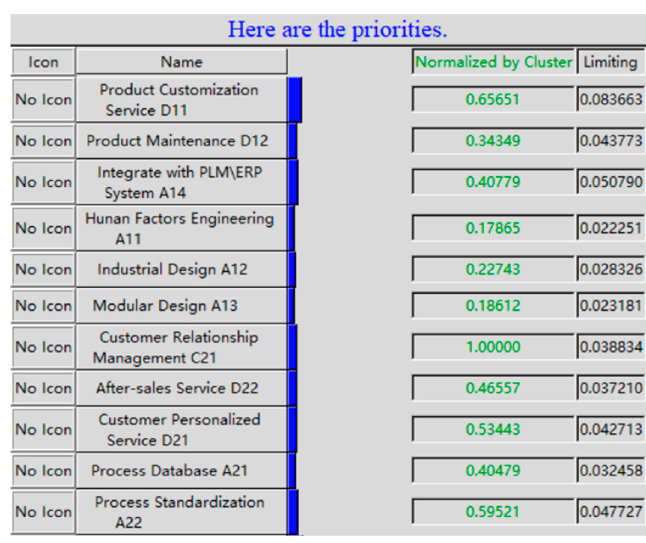
Figure 10. Global indicator weights of chair industry enterprises (partial data).